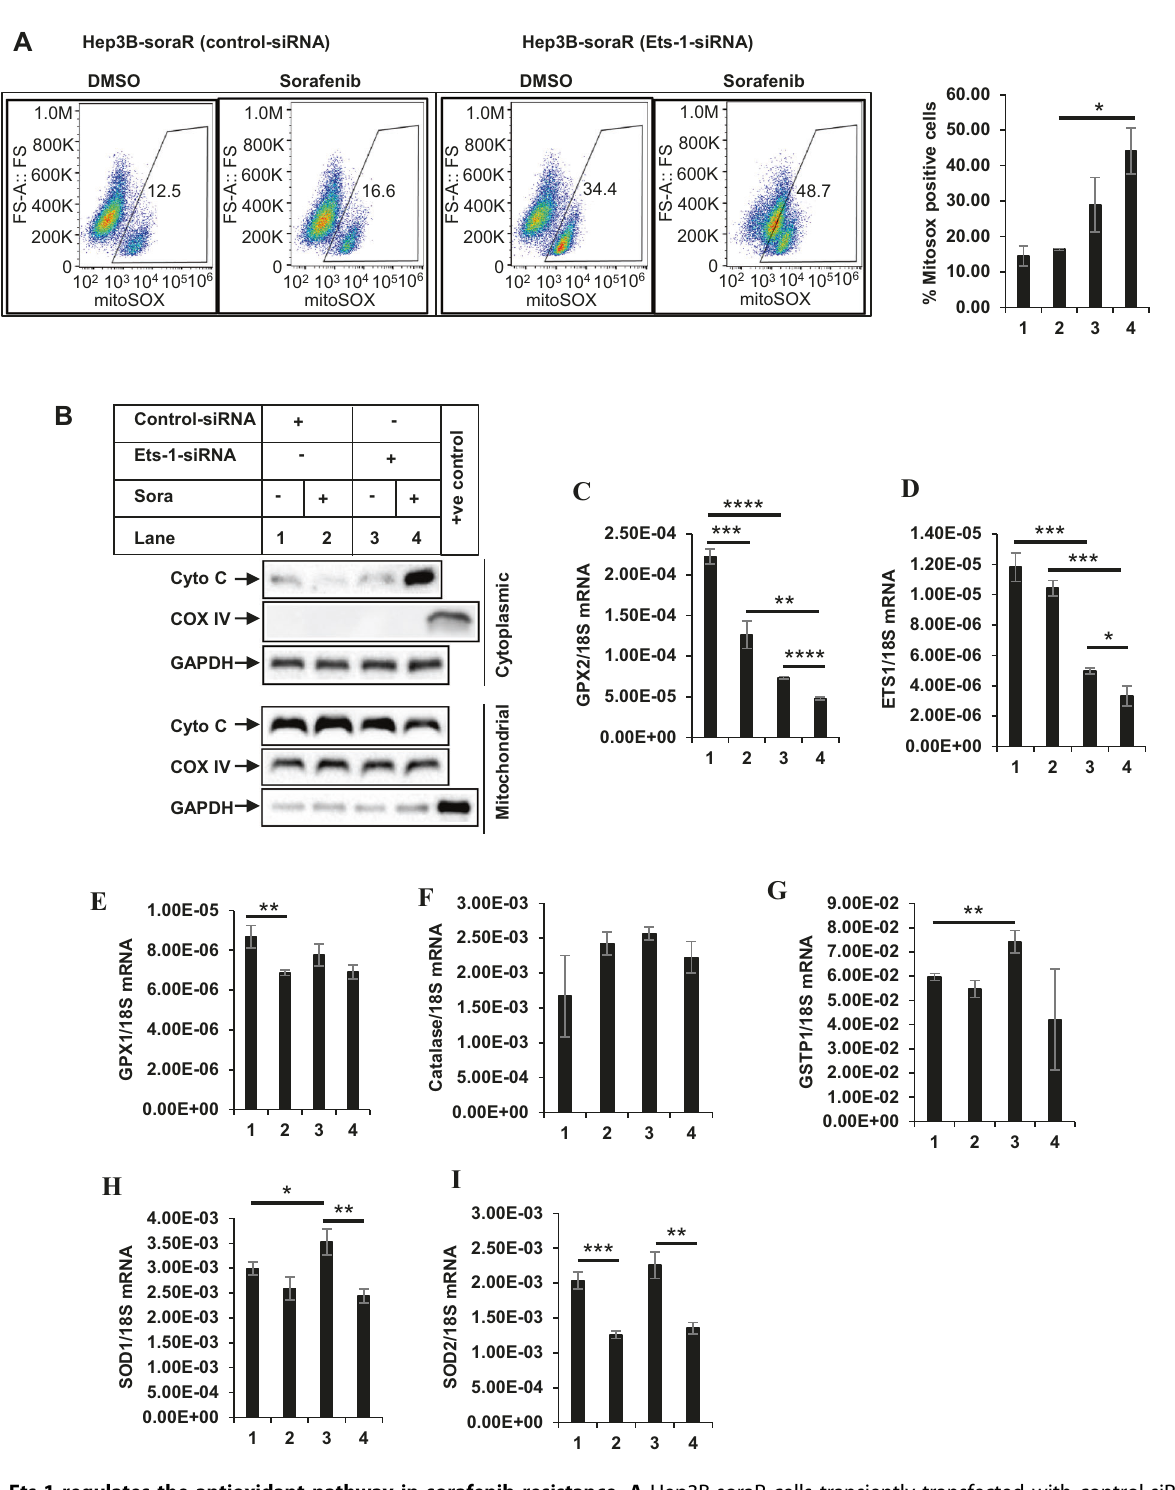
Fig. 7 Ets-1 regulates the antioxidant pathway in sorafenib resistance. A Hep3B-soraR cells transiently transfected with control-siRNA or Ets-1-siRNA were treated with DMSO or sorafenib (6 µM) for 24 h and analyzed by fl ow cytometry to detect mROS, as described in Fig. 2E. The bar graphs on the right represent the degree of mROS induction under each condition. The data represent the mean ± S.D. of two independent experiments. B Hep3B-soraR cells transfected as in A were treated with DMSO or sorafenib for 36 h and subjected to mitochondrial and cytoplasmic fractionation and analyzed by western blots. Cyto C cytochrome C. C – I Hep3B-soraR cells transfected as in A were treated with DMSO or sorafenib for 24 h followed by RNA extraction and qPCR analysis of the indicated genes. The data represent the mean ± S.D. of three independent PCR reactions. In all bar graphs, lanes 1 and 2 were transfected with control-siRNA, and lanes 3 and 4 were transfected with Ets-1-siRNA and treated with DMSO (lanes 1, 3) or sorafenib (lanes 2, 4). Signi fi cant differences were determined by t test and indicated as: * p ≤ 0.05; ** p ≤ 0.01; *** p ≤ 0.001; **** p ≤